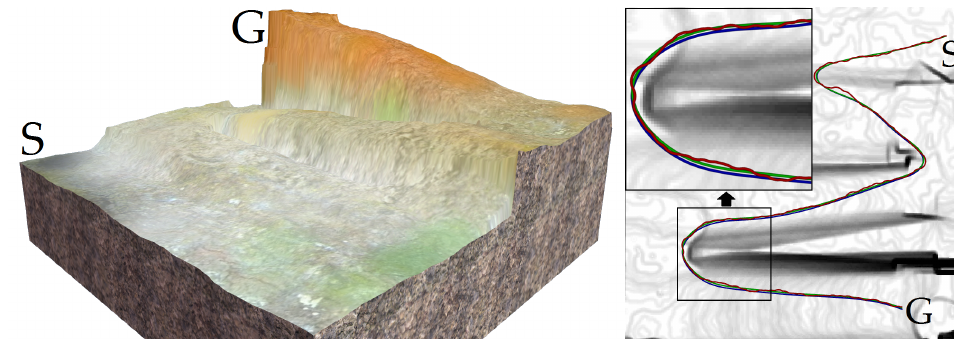
Figure 12. A virtual terrain surface and its traversability map.